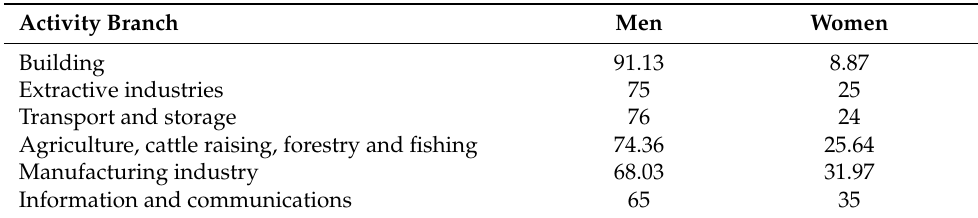
Table 1. Percentage distribution of employment by sectors in those activity branches with the highest proportion of male